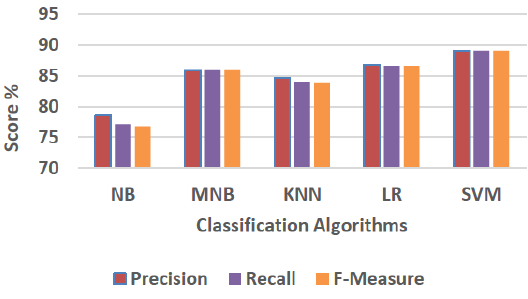
Figure 5: Sentiment prediction for D1.